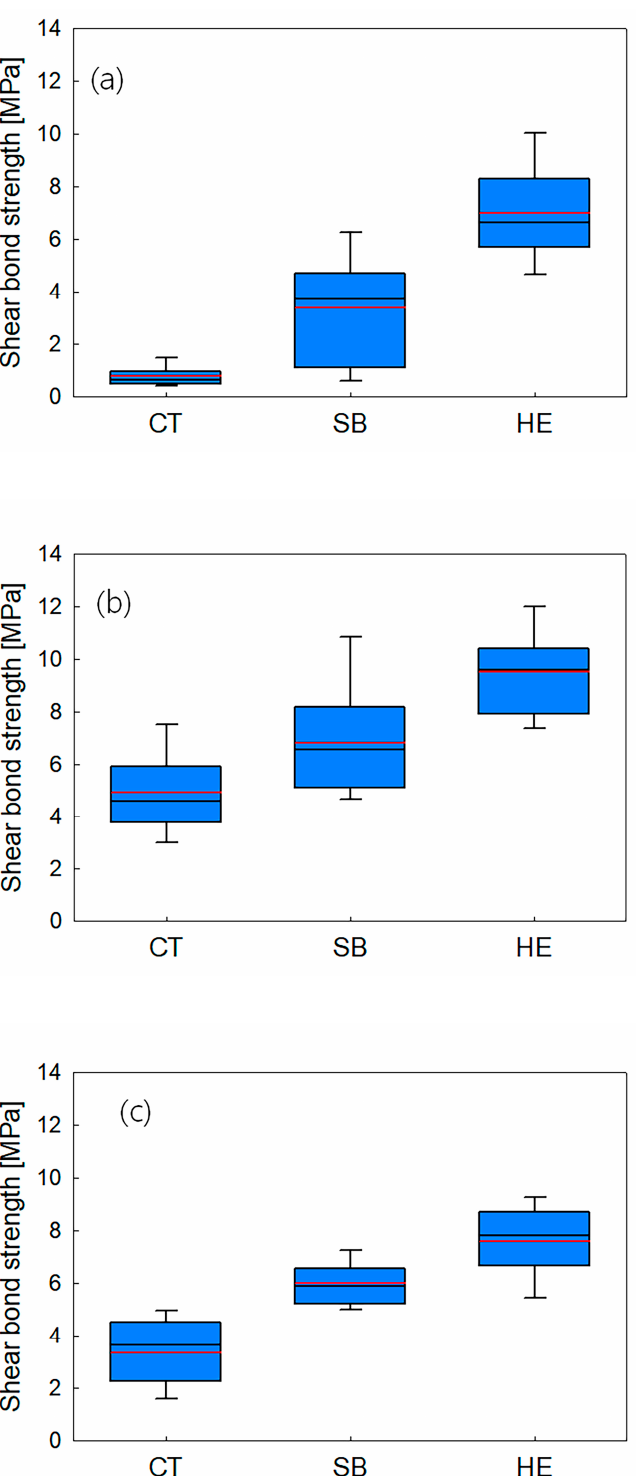
Figure 6. Shear bond strength graph between surface treatments and resin cements: ( a ) Maxcem Elite, ( b ) MAZIC cem, ( c ) RelyX U200. CT, control; SB, sandblasting; HE, hot-etching ( p < 0.05).